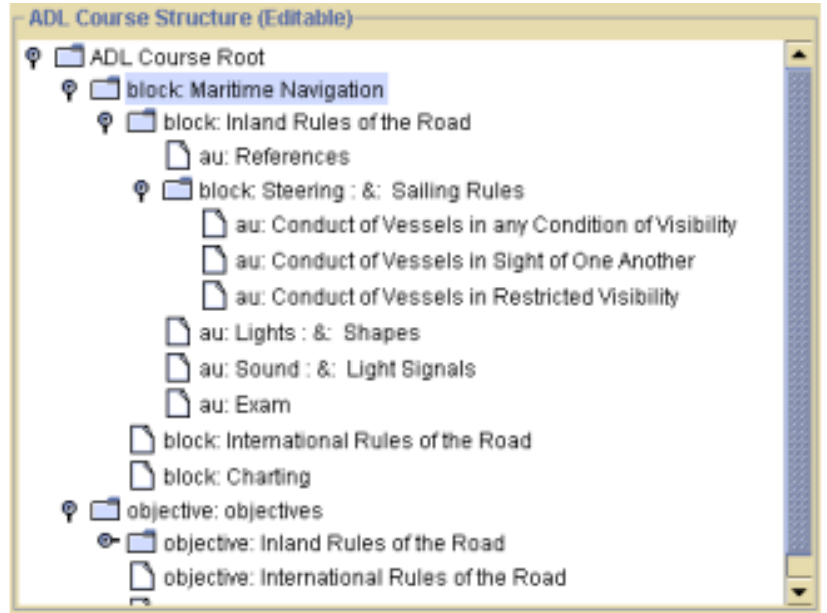
Figure 3: Sample Course Structure